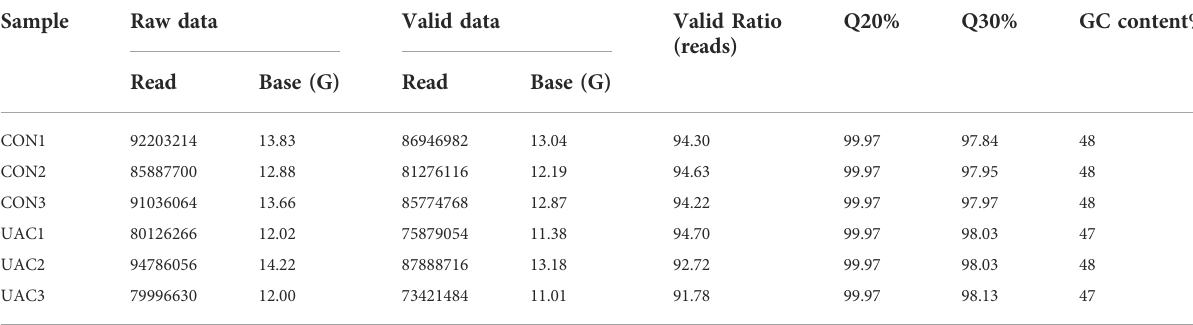
TABLE 2 Sequencing sequence statistics and quality control.